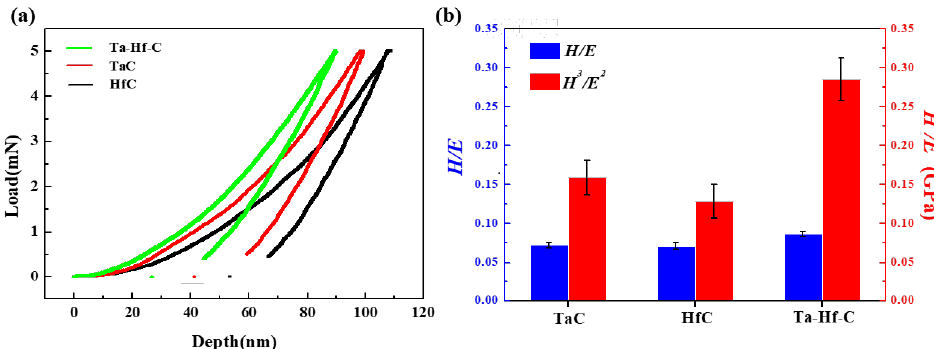
Figure 11. ( a ) The typical load–displacement curves of HfC, TaC, and Ta-Hf-C coatings; ( b ) H / E and H 3 / E 2 plasticity index of HfC, TaC, and Ta-Hf-C coatings. Plastic index H / E and plastic deformation resistance H 3 / E 2 indicates the toughness and plastic deformation resistance of the coating. For wear-resistant coatings with protective effects, the higher the value of plastic index, the better [19]. The values of H / E of TaC, HfC, and Ta-Hf-C coatings are 0.072 ± 0.003, 0.071 ± 0.004, and 0.087 ± 0.003, 0.129 ± 0.021 GPa, and 0.285 ± 0.028 GPa, respectively, which are significantly higher than